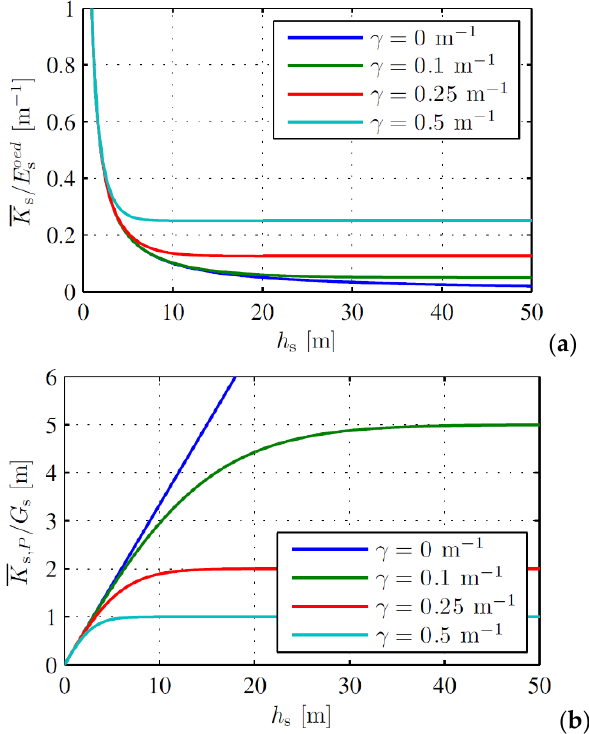
h for different values of  s